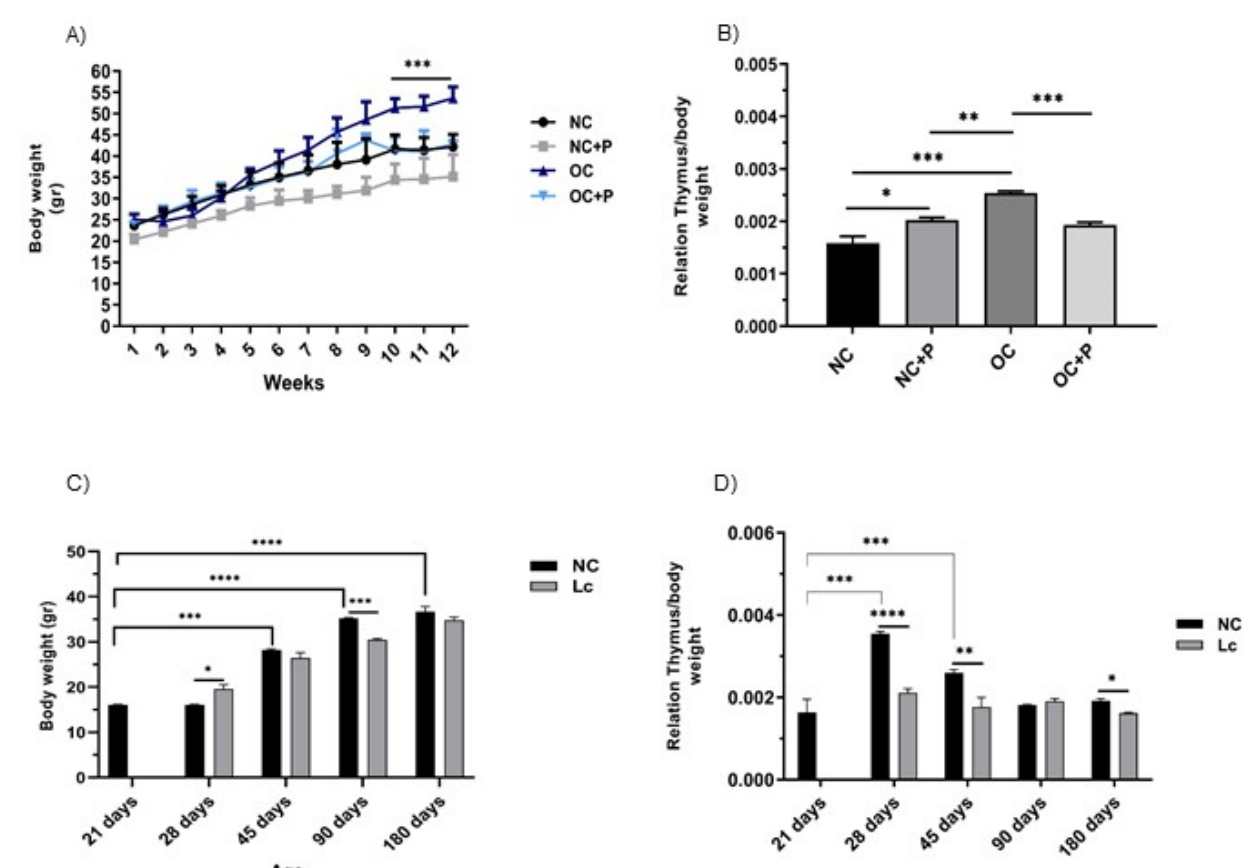
Figure 1. Body and thymus weight changes in senescence and obesity animal models. Mice were weighed every week during the experience. On the day of sacrifice, the thymus weight of each animal was also registered. Each point represented the average ± SD of the weight data pooled from 3 independent experiments with 3 mice per group. ( A ) Body weight differences registered in normal control mice (NC); normal control mice that received a conventional diet and supplementation with the probiotic bacteria (CN+P); obese mice (OC), and obese mice that received the HFD and probiotic supplementation (OC+P). ( C ) Body weight curves of mice at different ages (21, 28, 45, 90 and 180 days of age). The thymus/body weight ratio was calculated by dividing the organ weight by the body weight for ( B ) the group of obese mice and ( D ) mice at different ages. One-way ANOVA with Tukey’s correction for multiple comparisons * p < 0.05; ** p < 0.001; *** p < 0.001; **** p < 0.0001.